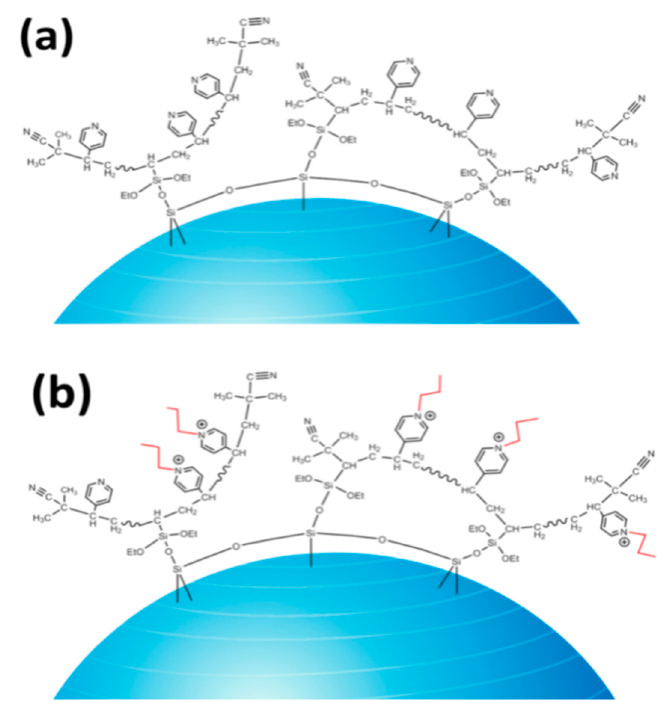
Figure 6. Surface morphology of SG-VTS-VP ( a ) and SG-VTS-VPQ ( b ).